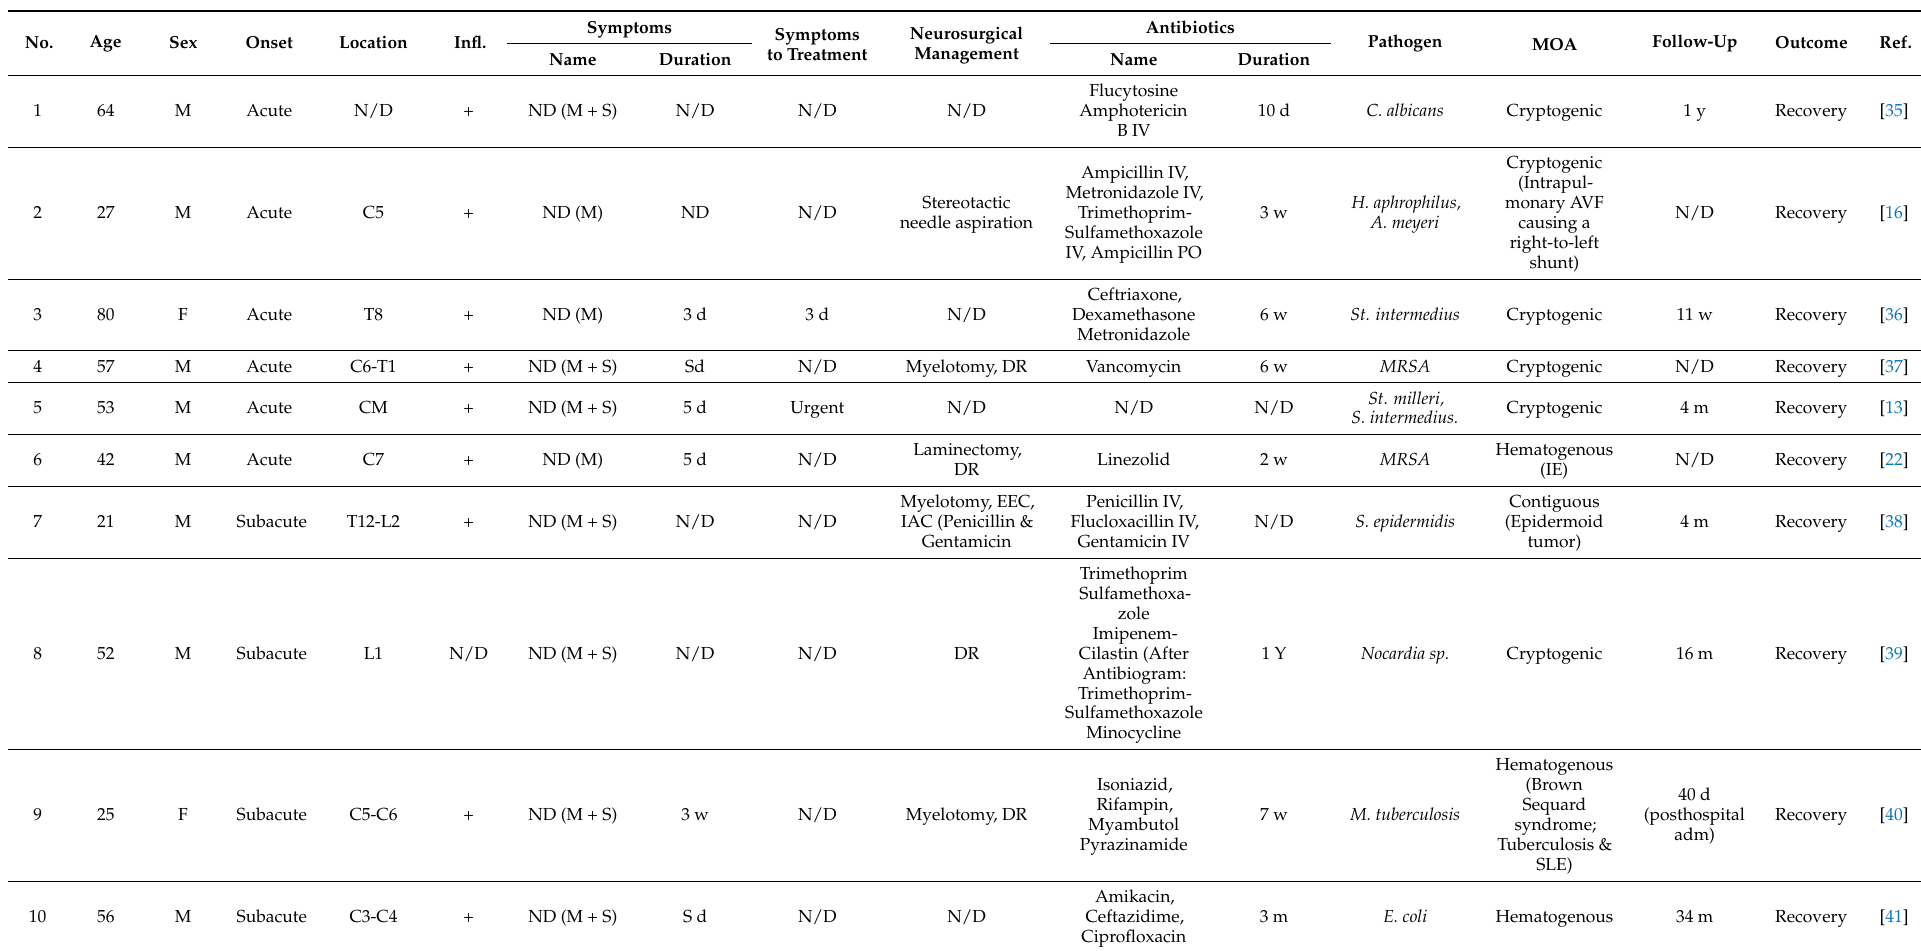
Table 1. Recovery group—summary of the clinical data, patient demographics, clinical manifestations, duration, microbiology, interventions and therapies,